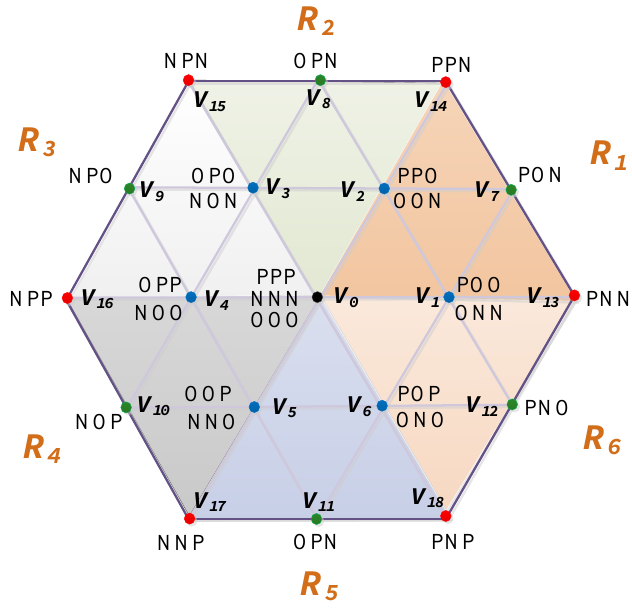
Figure 4. Proposed voltage space voltage vector diagram.